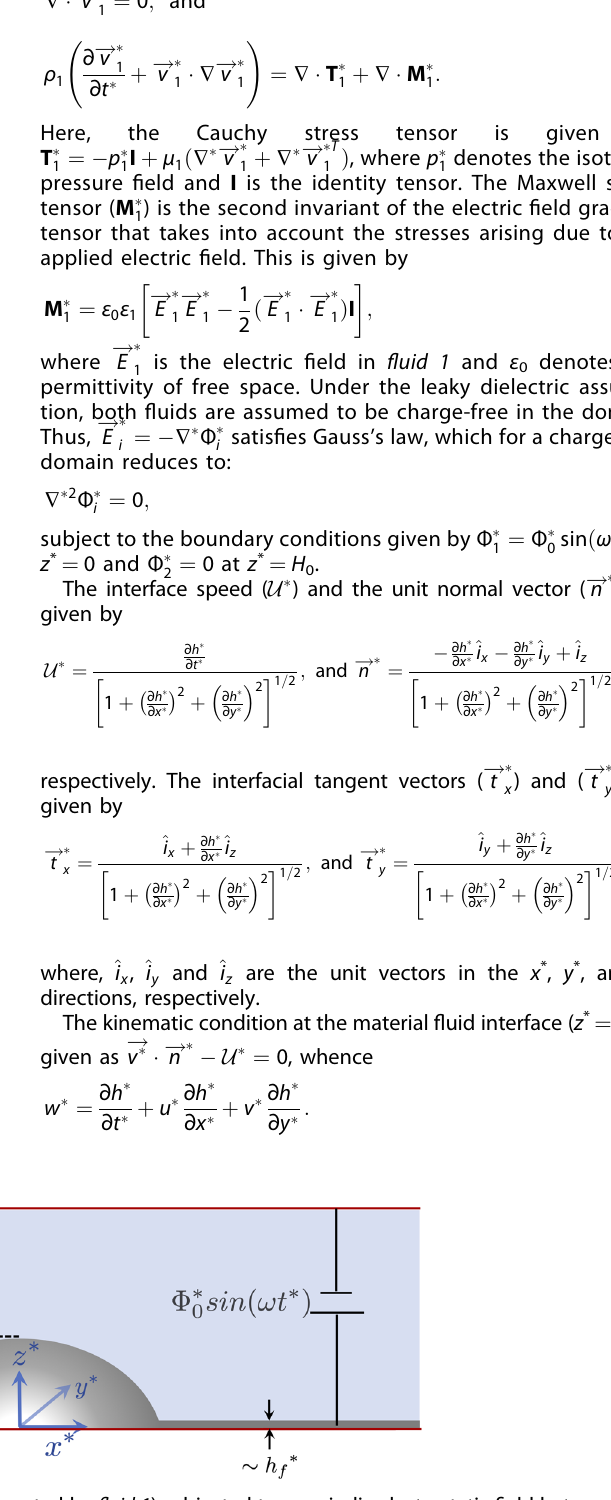
Fig. 1 Schematic diagram. A three-dimensional sessile droplet (designated by fl uid 1 ) subjected to a periodic electrostatic fi eld between two planar electrodes separated by a distance H 0 . The droplet is hydrodynamically active, while the ambient fl uid (designated by fl uid 2 ) is assumed to be hydrodynamically passive. Note that the precursor fi lm thickness is Oð h (cid:2)